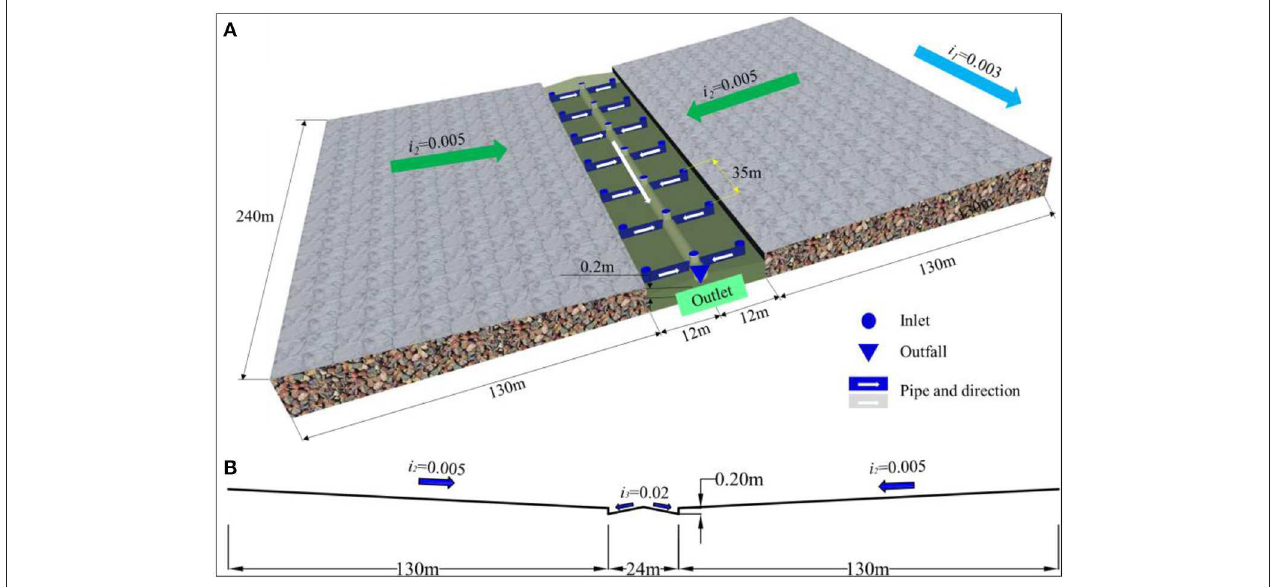
FIGURE 5 | Schematic diagram of the ideal urban catchment ( A : Stereogram and drainage-pipe layout; B : cross-section diagram).